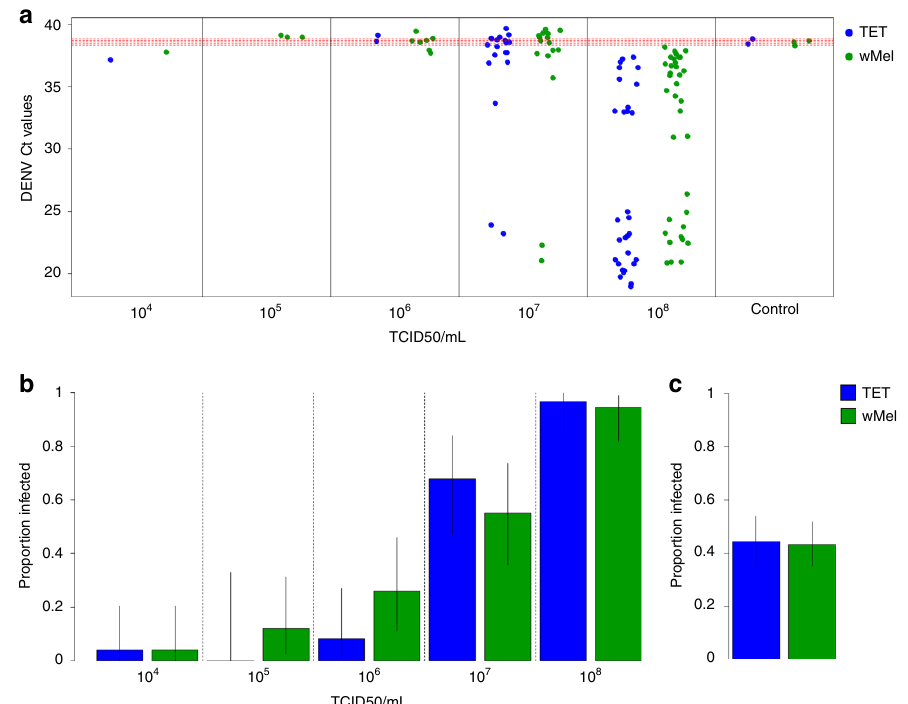
Fig. 1 qPCR data and DENV infection rates from the original Souto-Maior et al. 4 data. a Raw DENV qPCR Ct values resulting from intrathoracic inoculations. Blue and green dots show Ct values from TET and w Mel mosquitoes, respectively. Red dashed lines show Ct values from mock-injected negative controls. b – c Proportions of TET and w Mel mosquitoes classi fi ed by Souto-Maior et al. 4 (and likewise by King et al. 3 ) as qPCR positive — proportions have been recalculated from the original dataset. Error bars show 95% binomial con fi dence intervals.